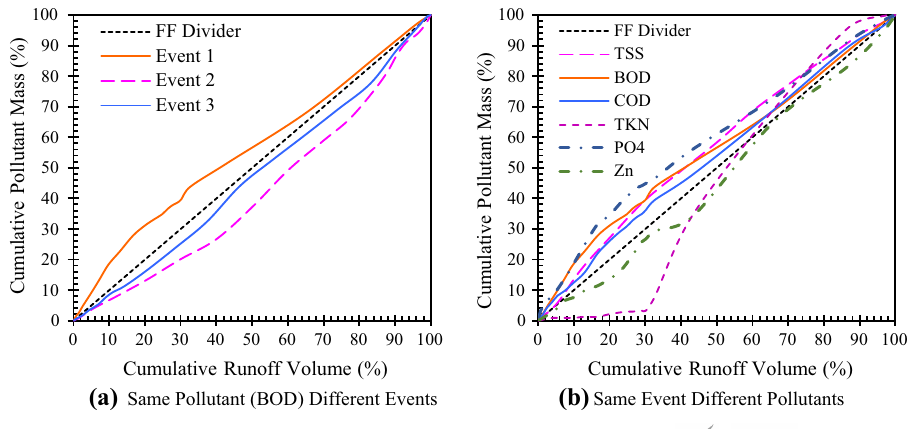
Fig. 2 Variation in the first- flush curve (double-storey terrace houses in